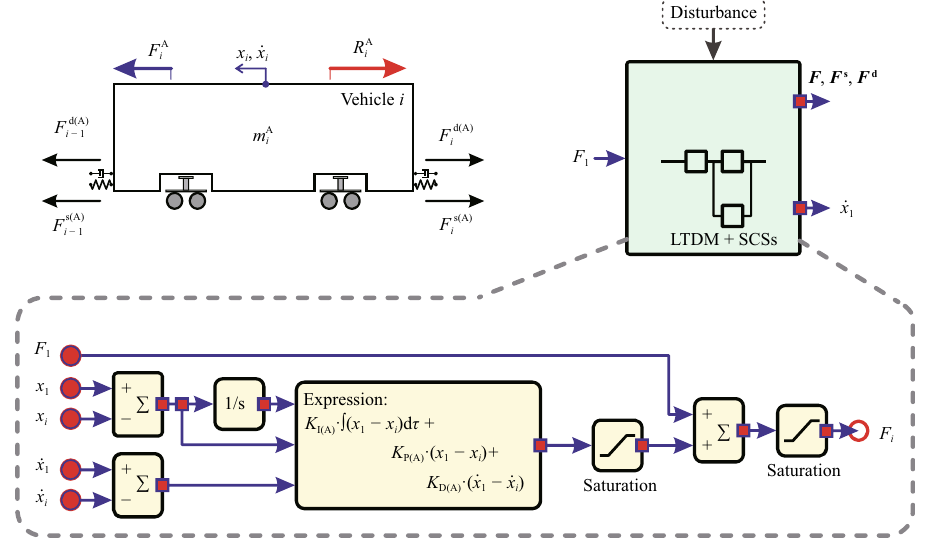
Fig. 8 Essential part of the block diagram of the slave control systems enabling the realization of the active vibration damping in the MUT inter- vehicle connections (all MUT carriages are